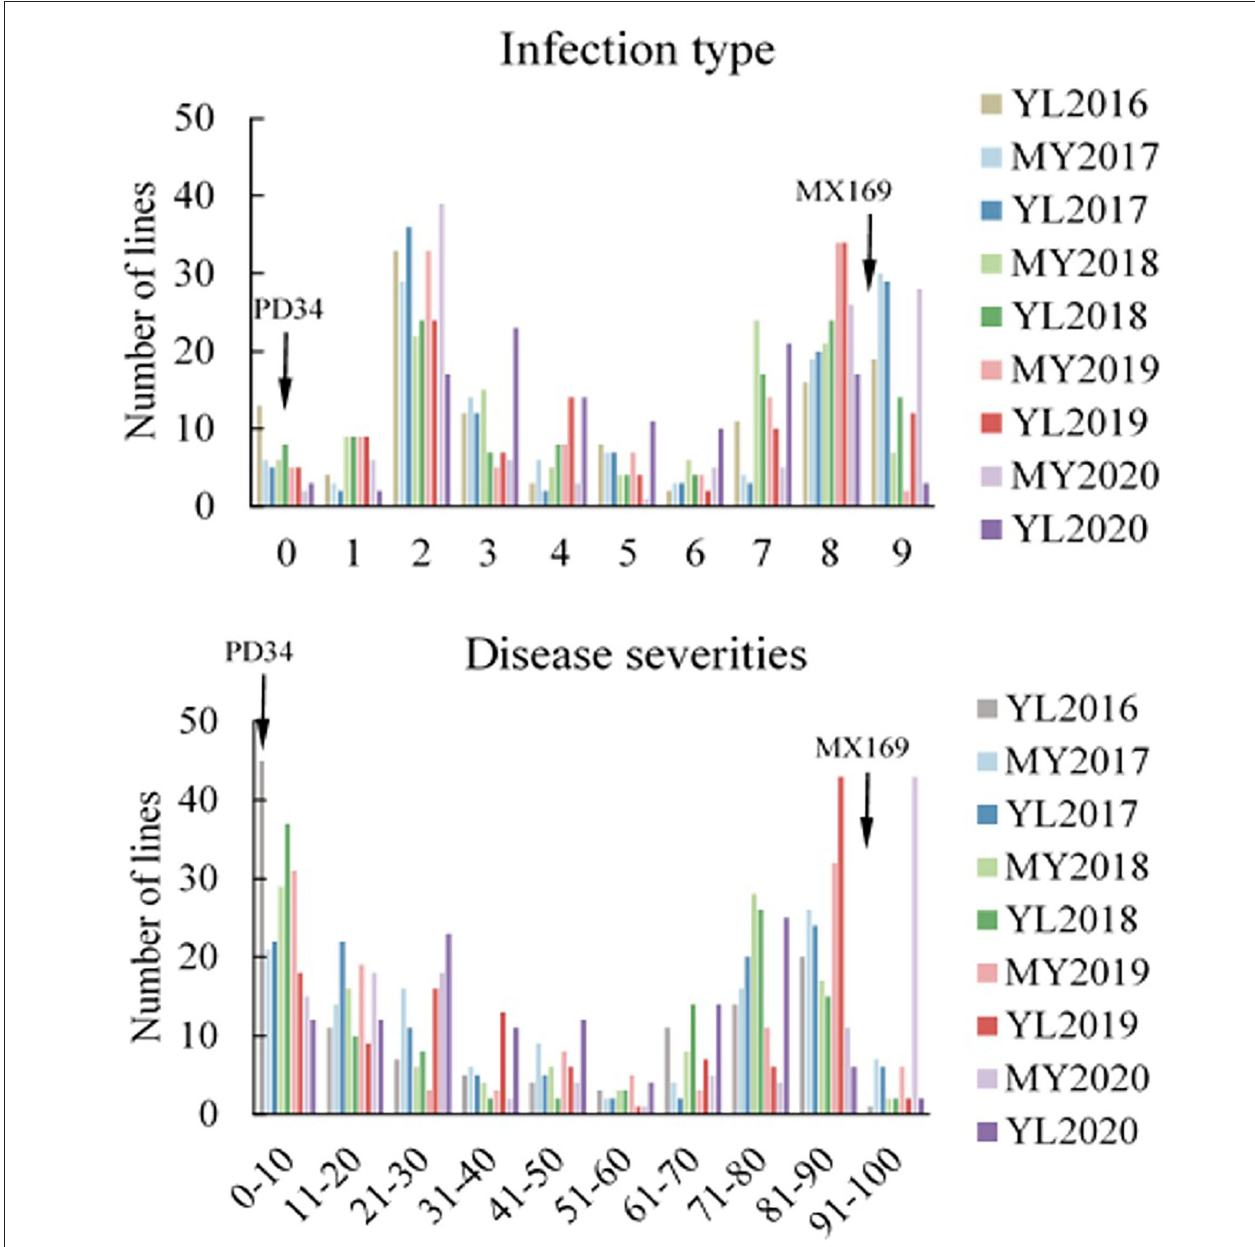
FIGURE 3 | Frequency distributions of the mean infection type (IT) and disease severity (DS) for 119 RILs from the cross of Mingxian 169 (MX) × Pindong 34 (PD) grown at Mianyang (MY) and Yangling (YL) in 2016–2020. Arrows indicate the values of the parental lines.